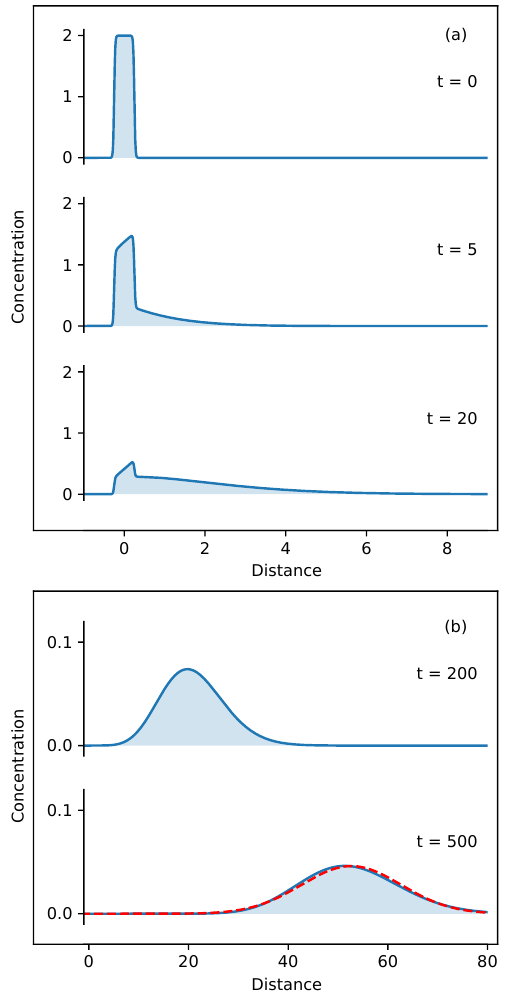
Figure 2. Evolution of the tracer concentration ( α = 0.1) obtained by numerically solving Eqs. (9) and (10). (a) Early entrainment regime. (b) Relaxation towards the diffusive regime. Tracers are ini- tially at rest, forming a symmetric plume of length L = 0.5 and mass M = 1. The concentration profile asymptotically tends towards a Gaussian distribution (dotted red